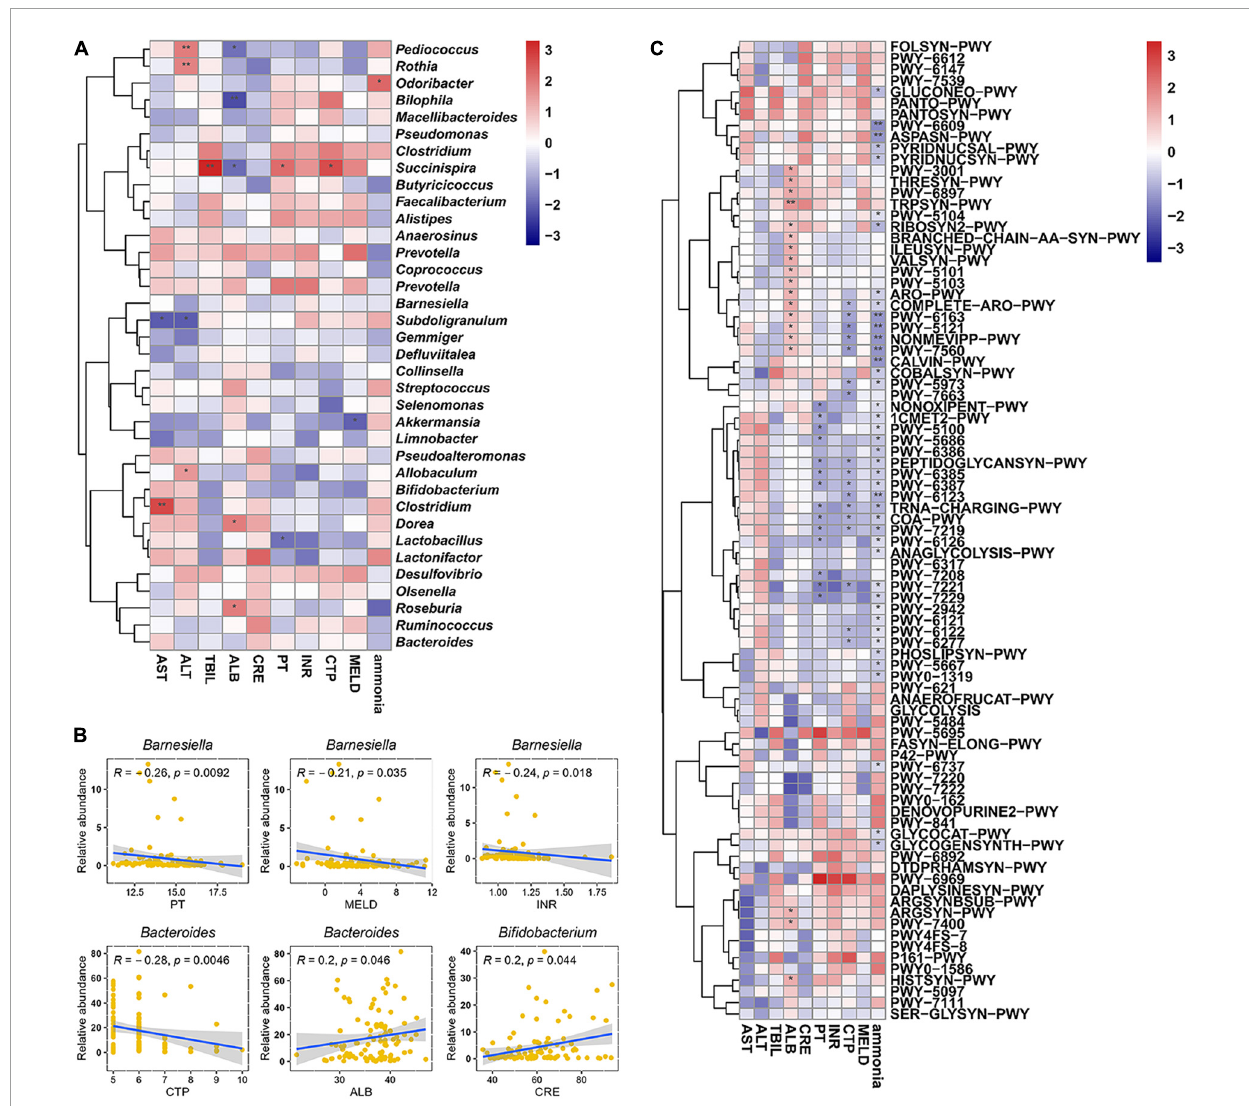
FIGURE7 Analysis of correlation. (A) Correlation coefficients between biomarkers and gut microbiota at genus level. (B) Key genus significantly correlated with different biomarkers. (C) Correlation coefficients between biomarkers and metabolic features. The Spearman correlation coefficients were calculated and labeled in the figure. AST, aspartate aminotransferase; ALT, alanine aminotransferase; ALB, serum albumin; TBIL, total bilirubin; PT, prothrombin time; INR, international normalized ratio; CRE, creatinine; CTP, Child–Turcotte–Pugh; MELD, model for end-stage liver disease. Statistically significances are indicated: * p < 0.05, ** p <